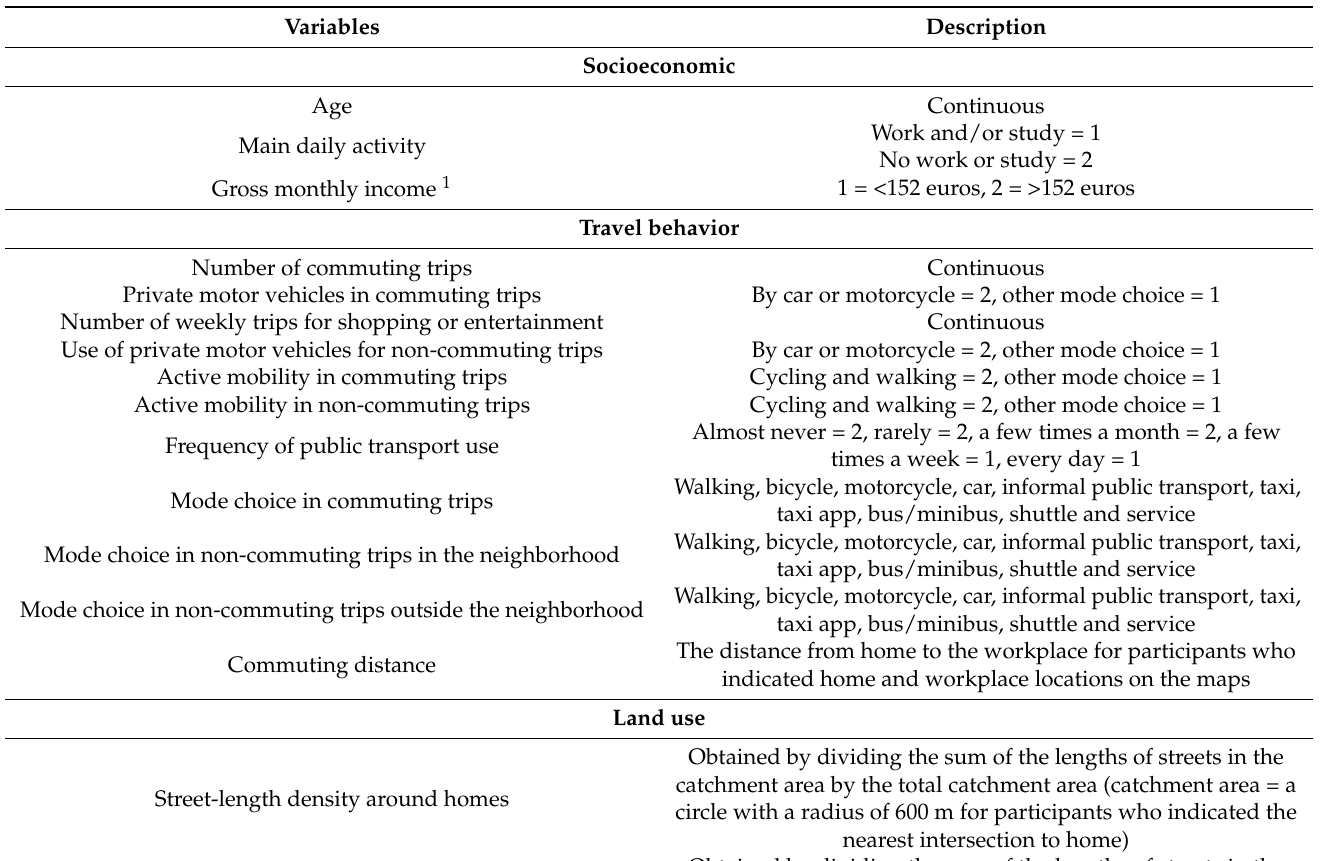
Table 1. Socioeconomic and travel behavior